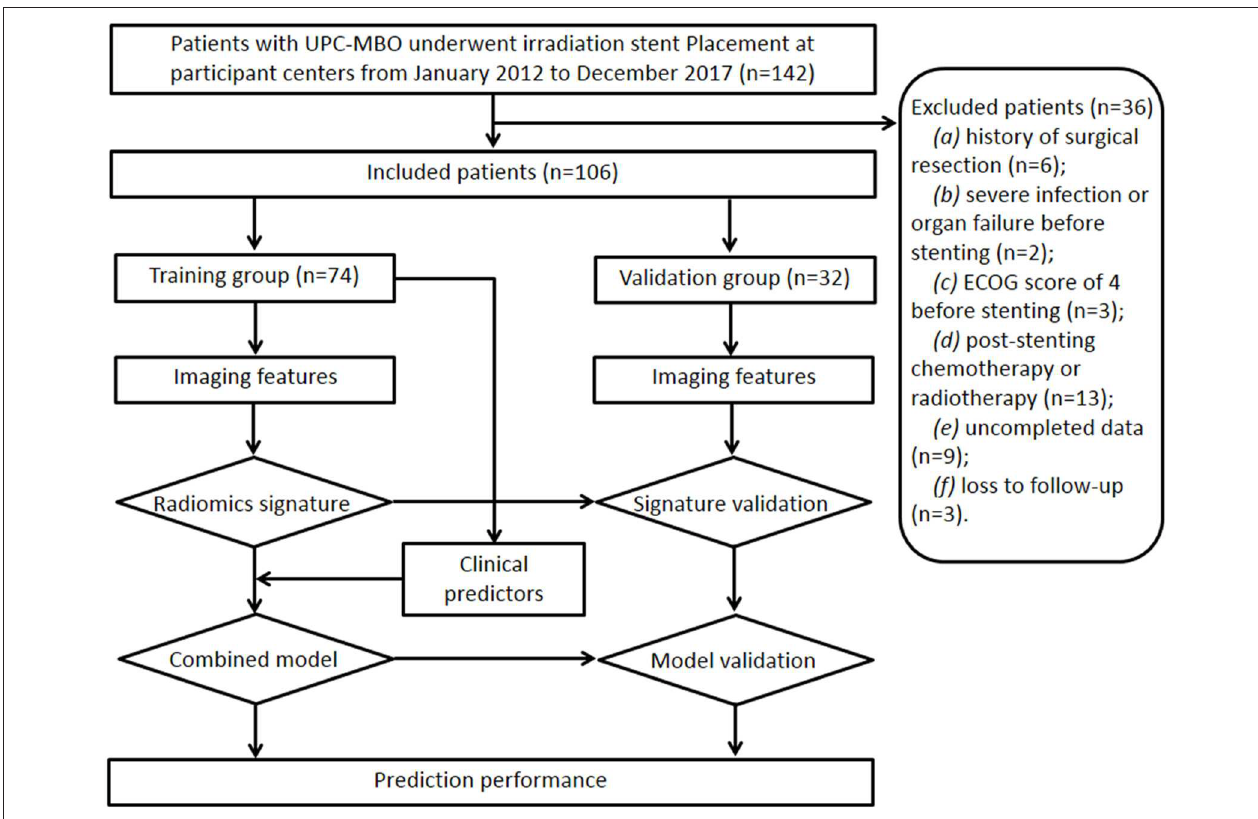
FIGURE 1 | Flowchart of the study design and patient